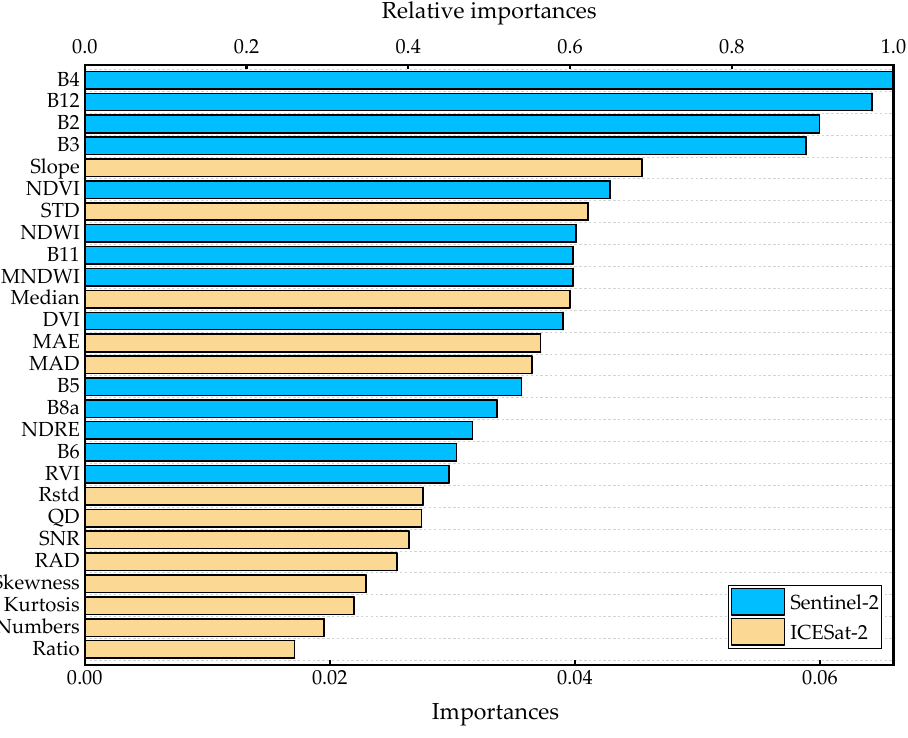
Figure 3. Distribution of characteristic importance. The feature importance is normalized to highlight the percentage of each variable. The blue column is the characteristic variable of Sentinel-2, whereas the yellow column corresponds to ICESat-2.